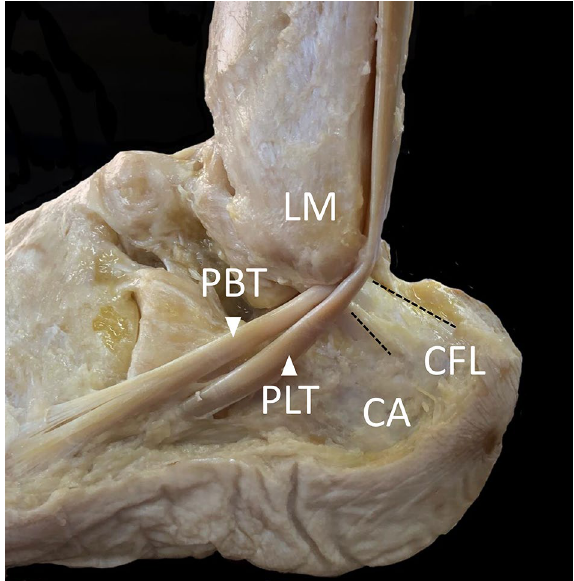
Figure 1. Structural relationship between the peroneus longus tendon (PLT), peroneus brevis tendon (PBT), and calcaneofibular ligament (CFL) in a left cadaveric ankle. The dashed line indicates the margin of the CFL. LM lateral malleolus, CA